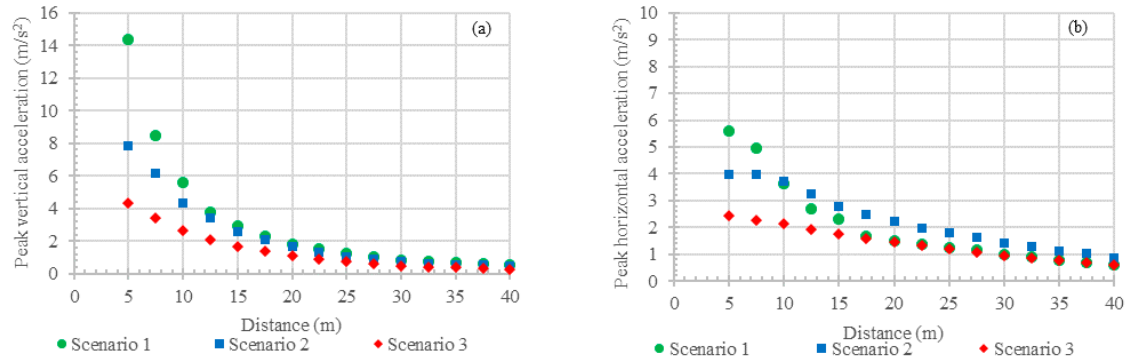
Figure 7. Comparison between different excavation scenarios: variation with distance of ( a ) peak vertical acceleration and ( b ) peak horizontal acceleration.